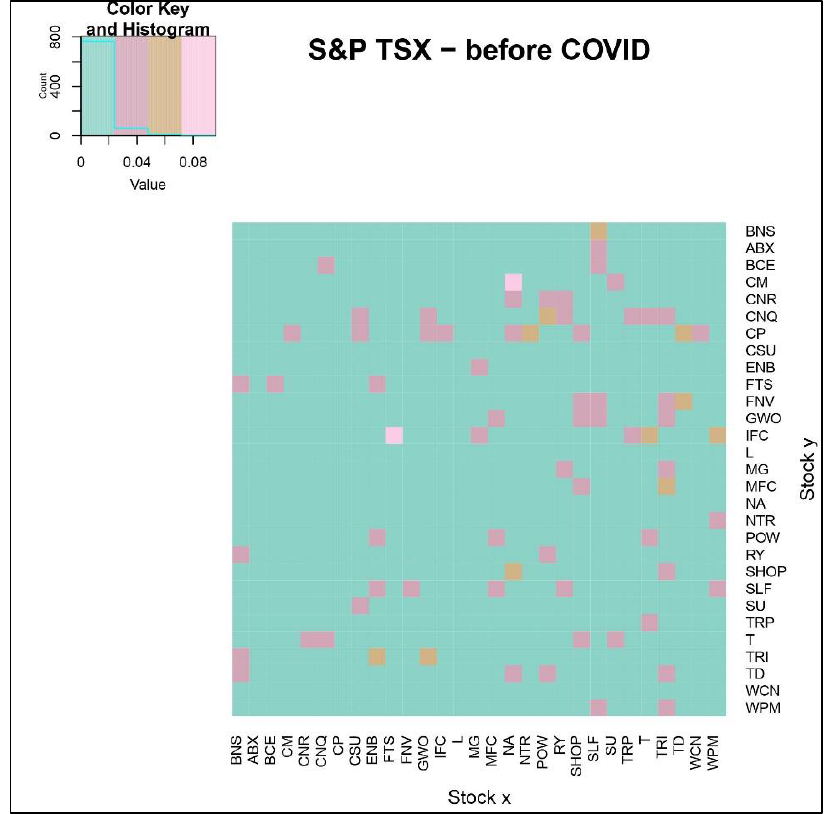
Figure 23. The information flow (effective transfer entropy) from stock y to stock x, for the top companies (by market capitalization) in the S&P TSX market, before the COVID-19 outbreak